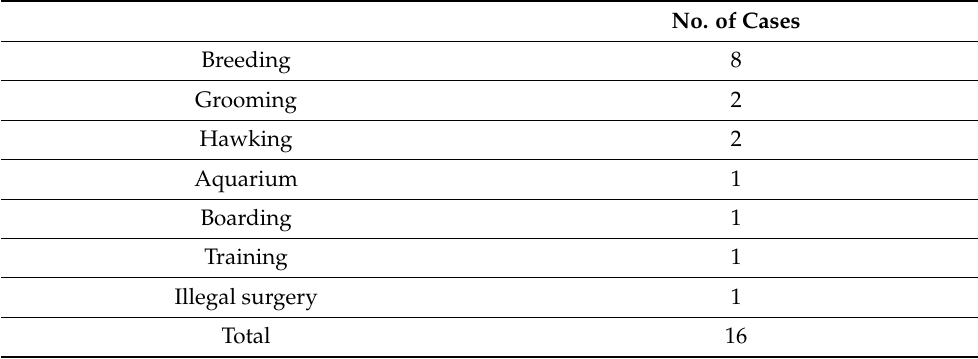
Table 3. Types of commercial